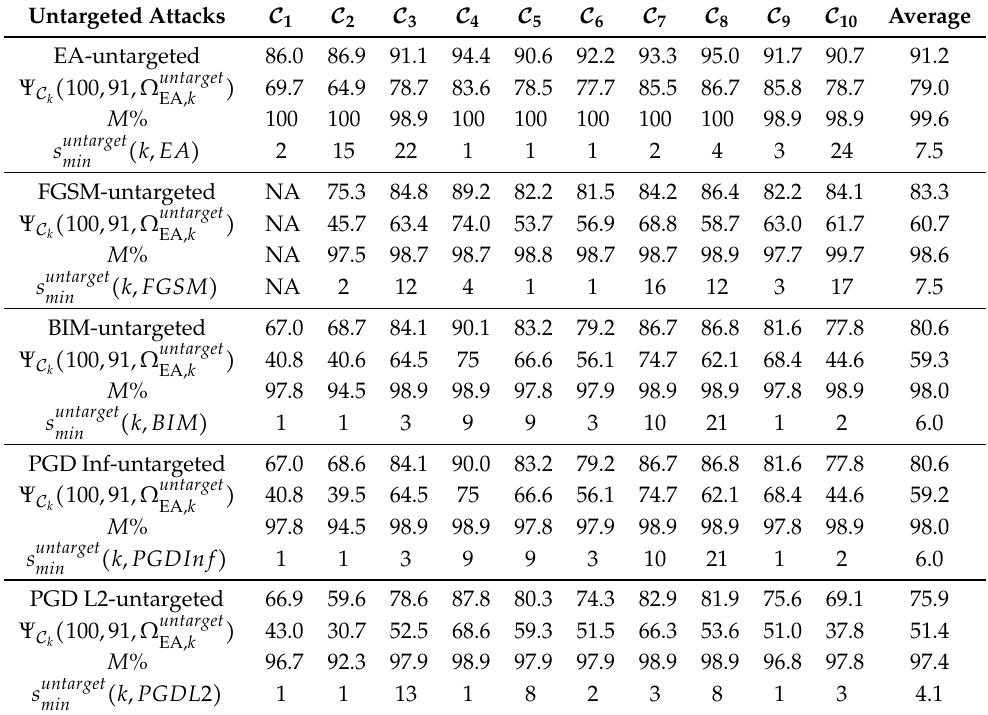
Table 7. For each C k , for each untargeted attack atk , the percentage s of the 100 permutations σ for (A p q )) , which the shuffled-by σ image of an adversarial image, namely ShuffleDetect C k σ (D atk , untargeted k ( 100,91, Ω untarget ) , of the maximum possible is declared adversarial on average, the assessment of Ψ C adv , k k ( k , adv ) detection rate M %, and of s untarget min